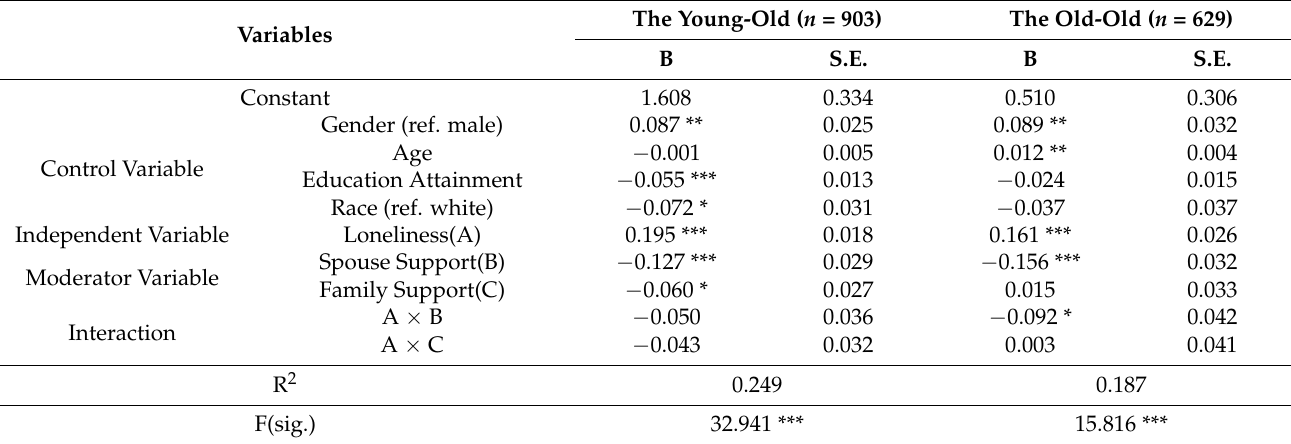
Table 3. Multivariate Regression Models of Depression among